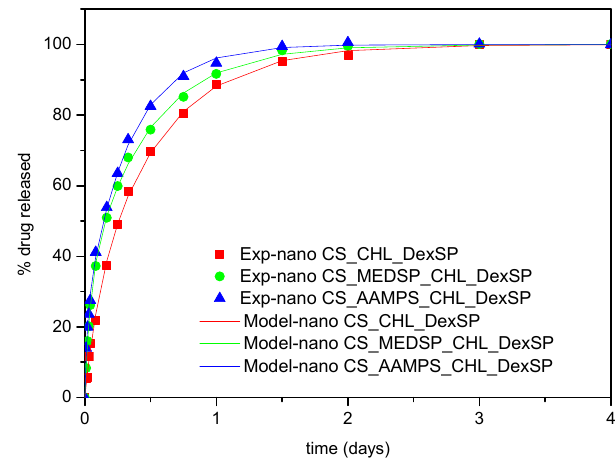
Figure 12. Comparison between model (solid lines) and experimental (symbols) release curves for DexSP in three types of nanoparticles.